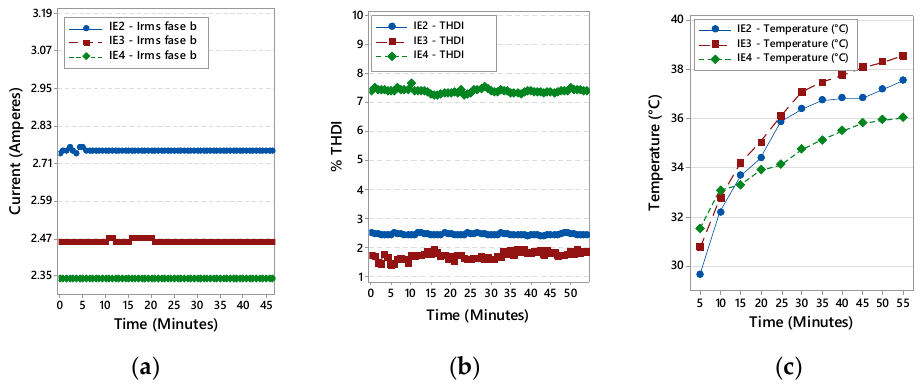
Figure 3. ( a ) Line currents for IE2, IE3 and IE4 induction motors (IM) classes; ( b ) total harmonic distortion of current for IE2, IE3 and IE4 IM classes; ( c ) temperature rise for IE2, IE3 and IE4 IM classes.